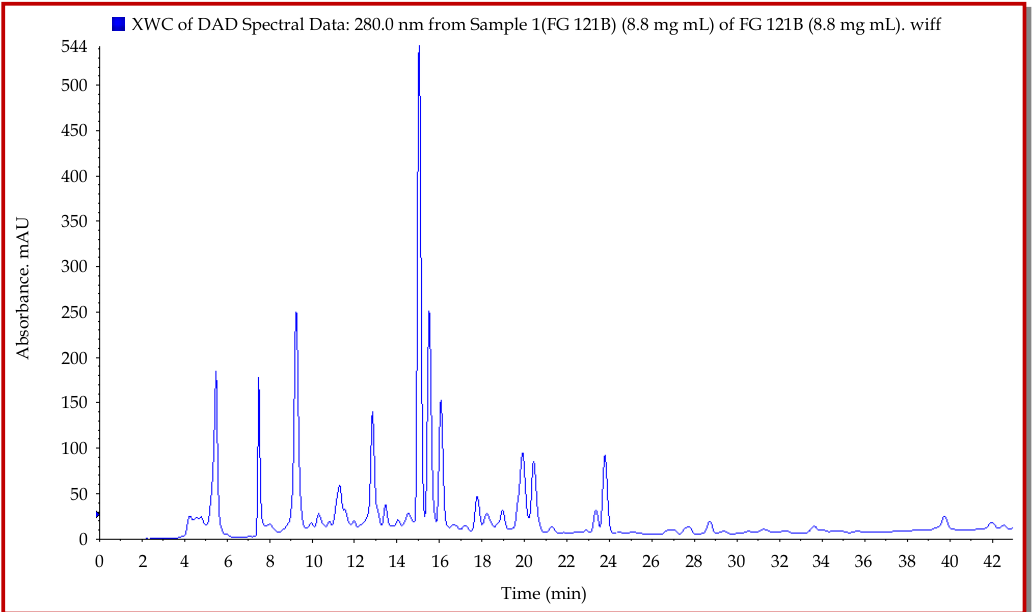
Figure 1: HPLC chromatogram of Nepeta cilicica methanol extract at 280